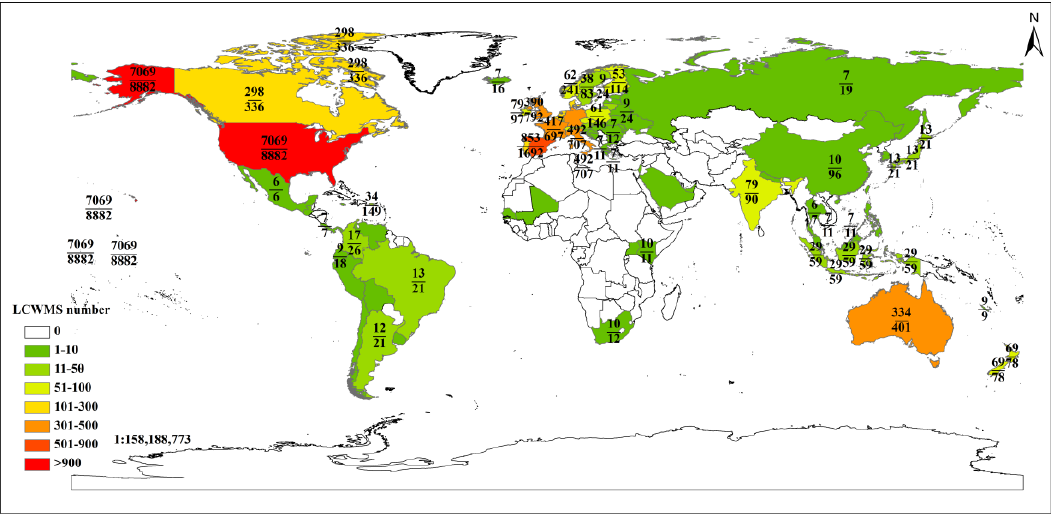
Figure 9. Spatial distribution and numbers of the discovered LCWMSs.